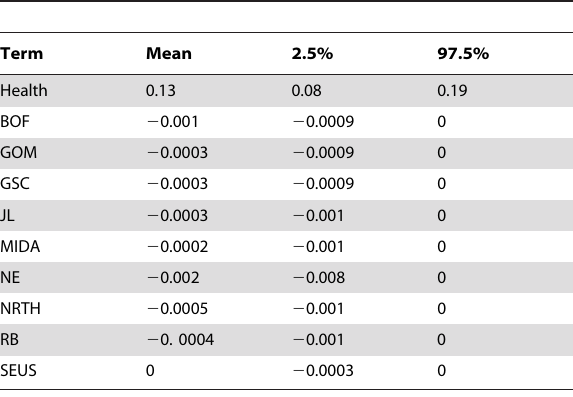
Table 2. Estimates for the parameters for survival as a function of health and location.